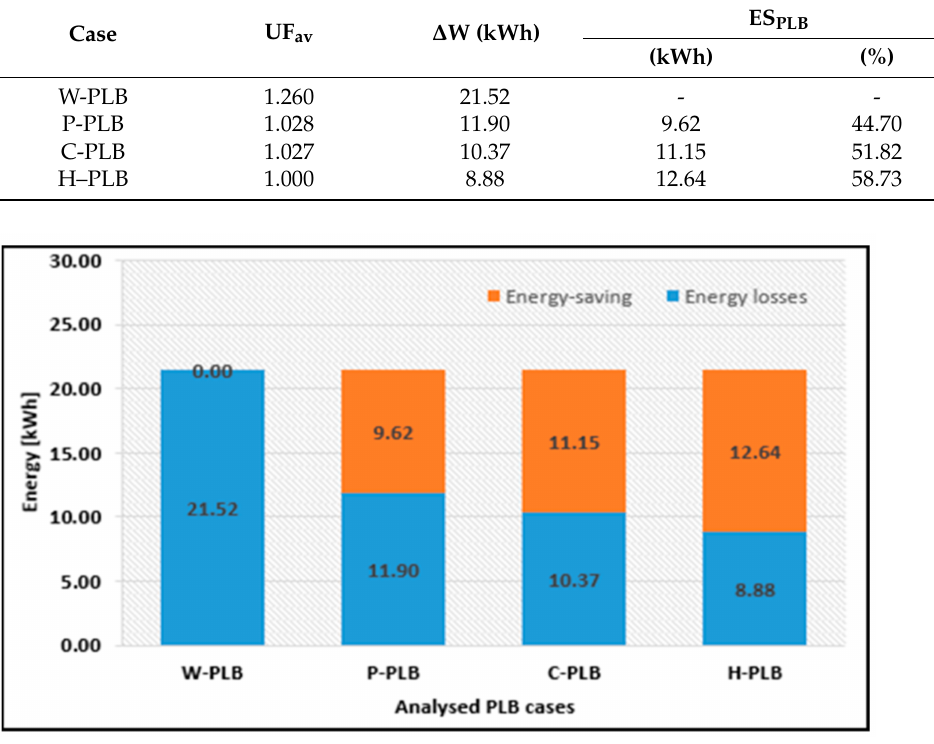
Figure 21. Comparison between the energy losses of the AEDN in the analysed PLB